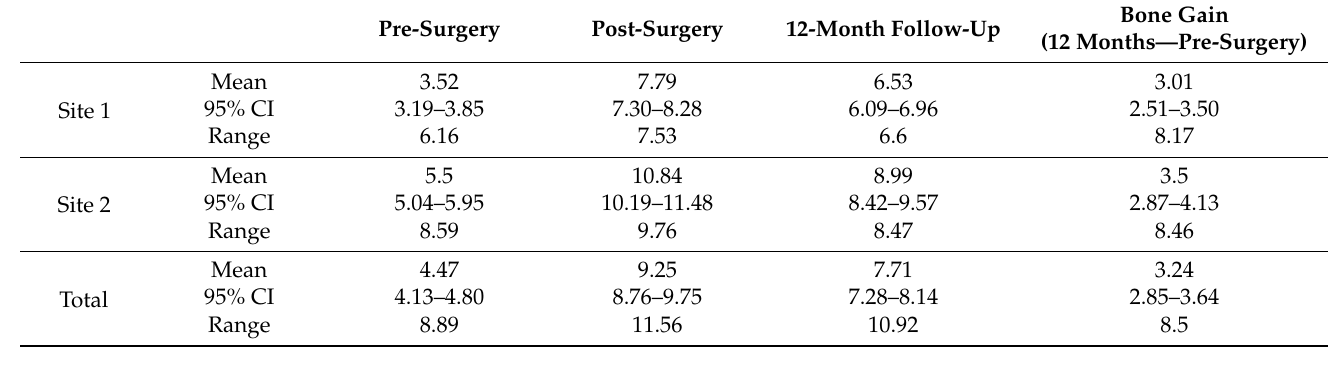
Table 1. Linear bone changes (in mm) for each location and overall at different evaluation times.